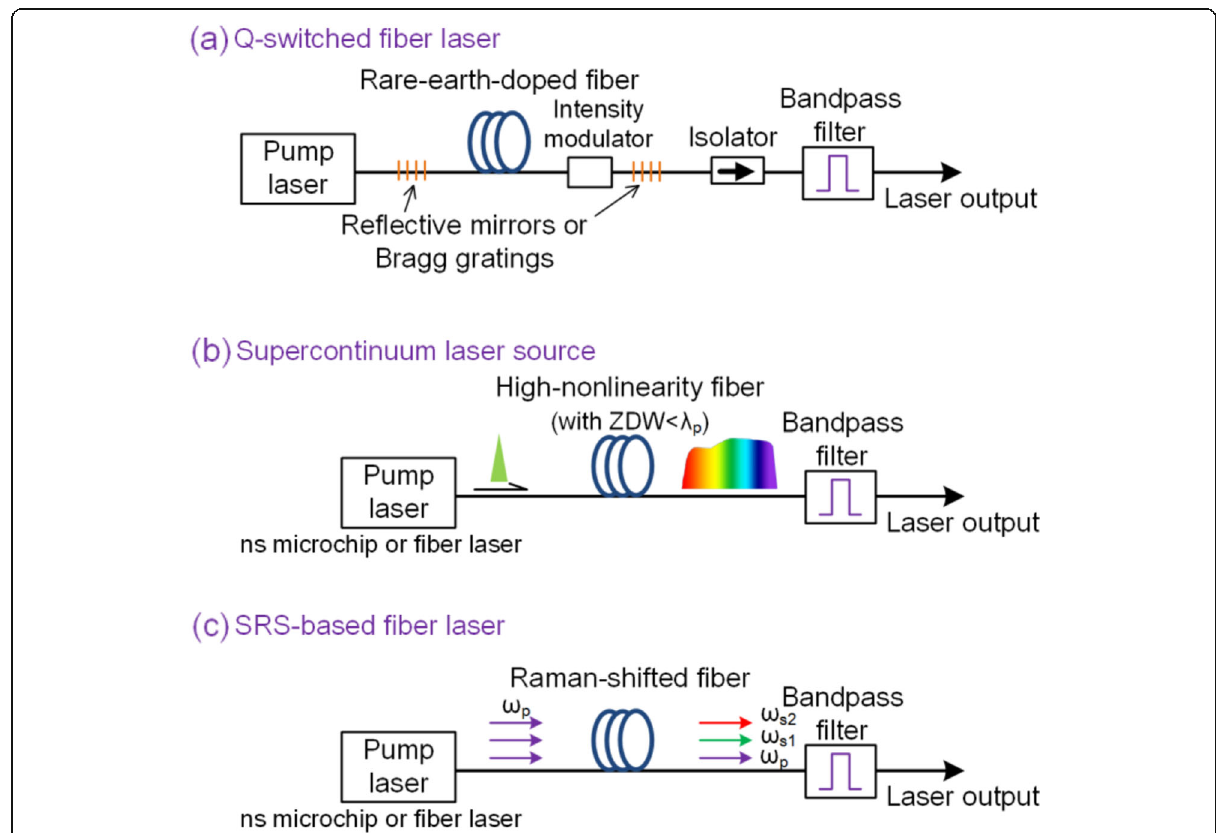
Fig. 2 Schematics of fiber laser sources for PAM. ( a ): Q-switched fiber laser; ( b ): Supercontinuum laser; and ( c ): SRS-based fiber